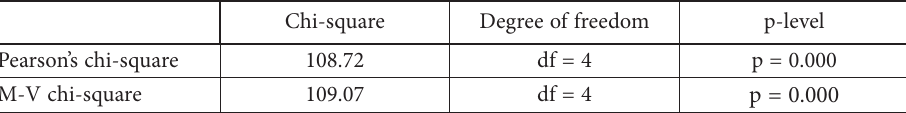
Table 10. χ 2 test for motivational factor good working team from the point of view of gender Chi-square Degree of freedom p-level Pearson’s chi-square 108.72